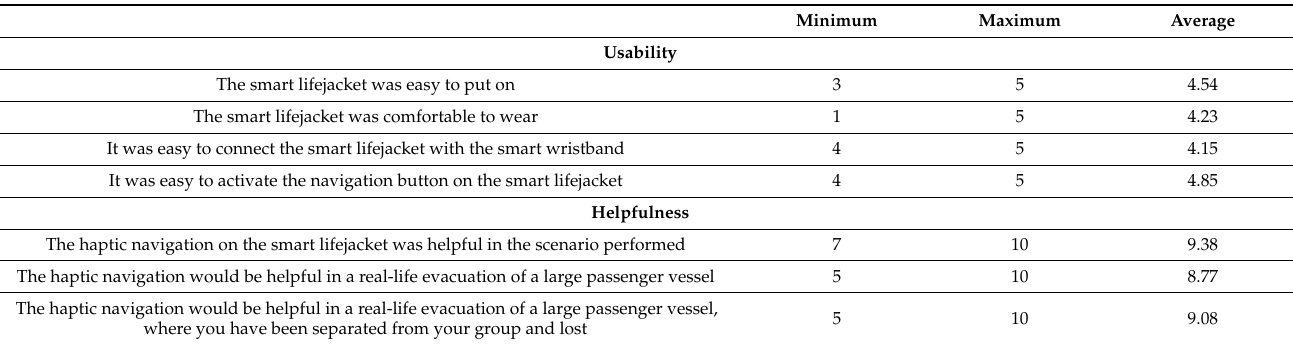
Table 2. Evaluation